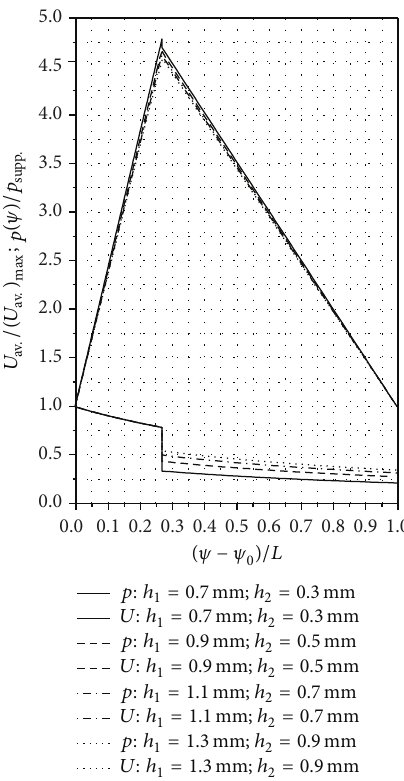
Figure 6: Pressure and speed distributions in the SATBESPIG with inner pumping. (See details in Figures 7 and